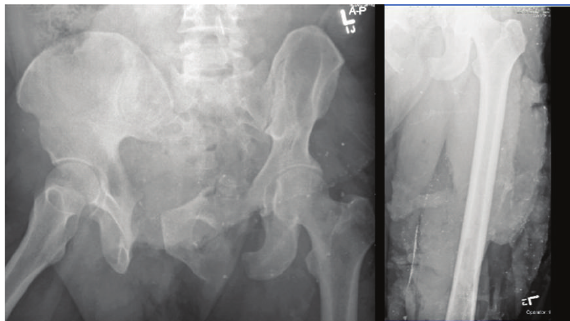
Figure 2: Laparotomy was performed where intra-abdominal bleeding was controlled and then the aorta and IVC clamped low in the abdomen to stop the blood loss from his pelvis and left lower extremity. INFIX